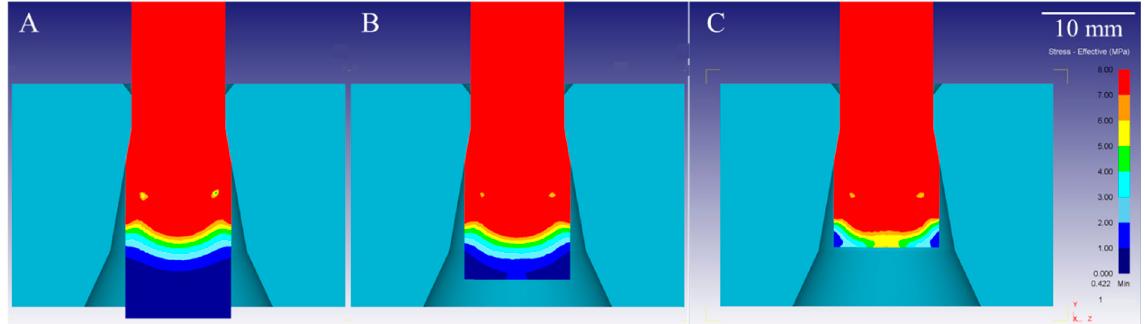
Figure 5. FEM analysis of the stress distribution during wire drawing process of copper: ( A ) stationary conditions; ( B ) non-stationary conditions; ( C ) non-stationary conditions, end of the process.